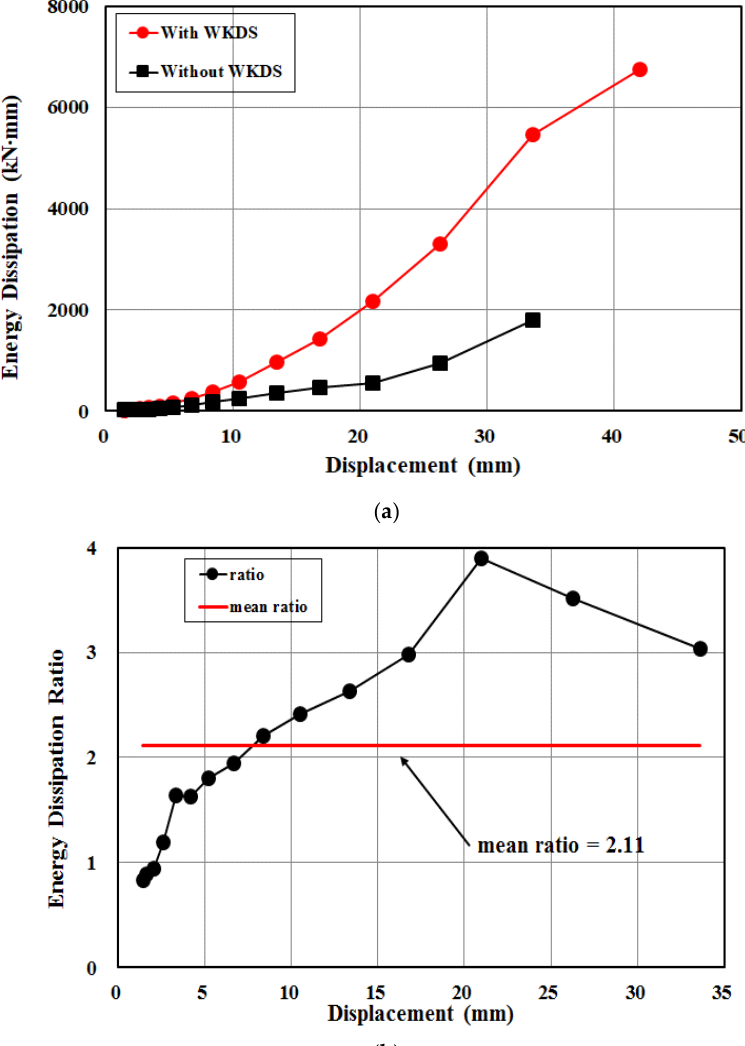
Figure 18. Energy dissipation of specimens. ( a ) Variation of E D, ( b ) Ratio of the E D .